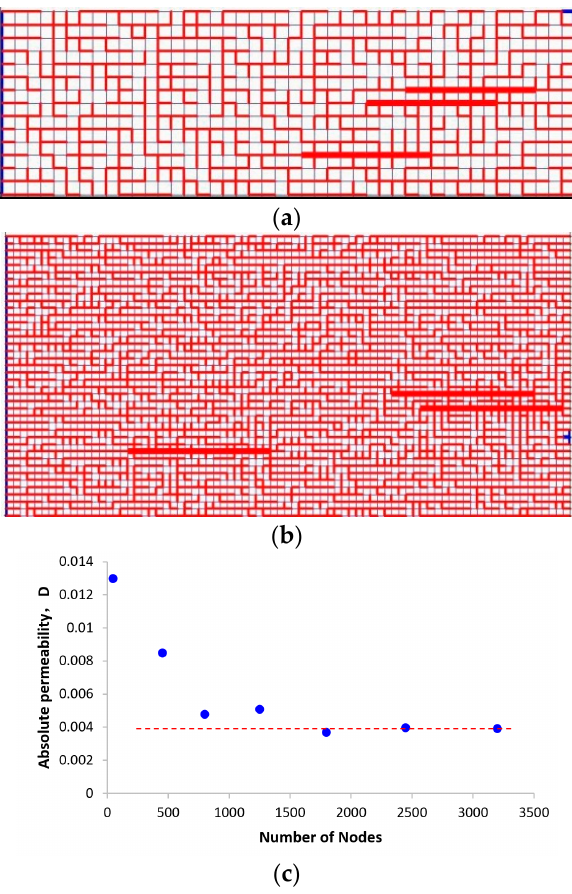
Figure 2. PFNM in different scales. ( a ) 15 × 60; ( b ) 50 × 100; ( c ) Representative scale for simulations.